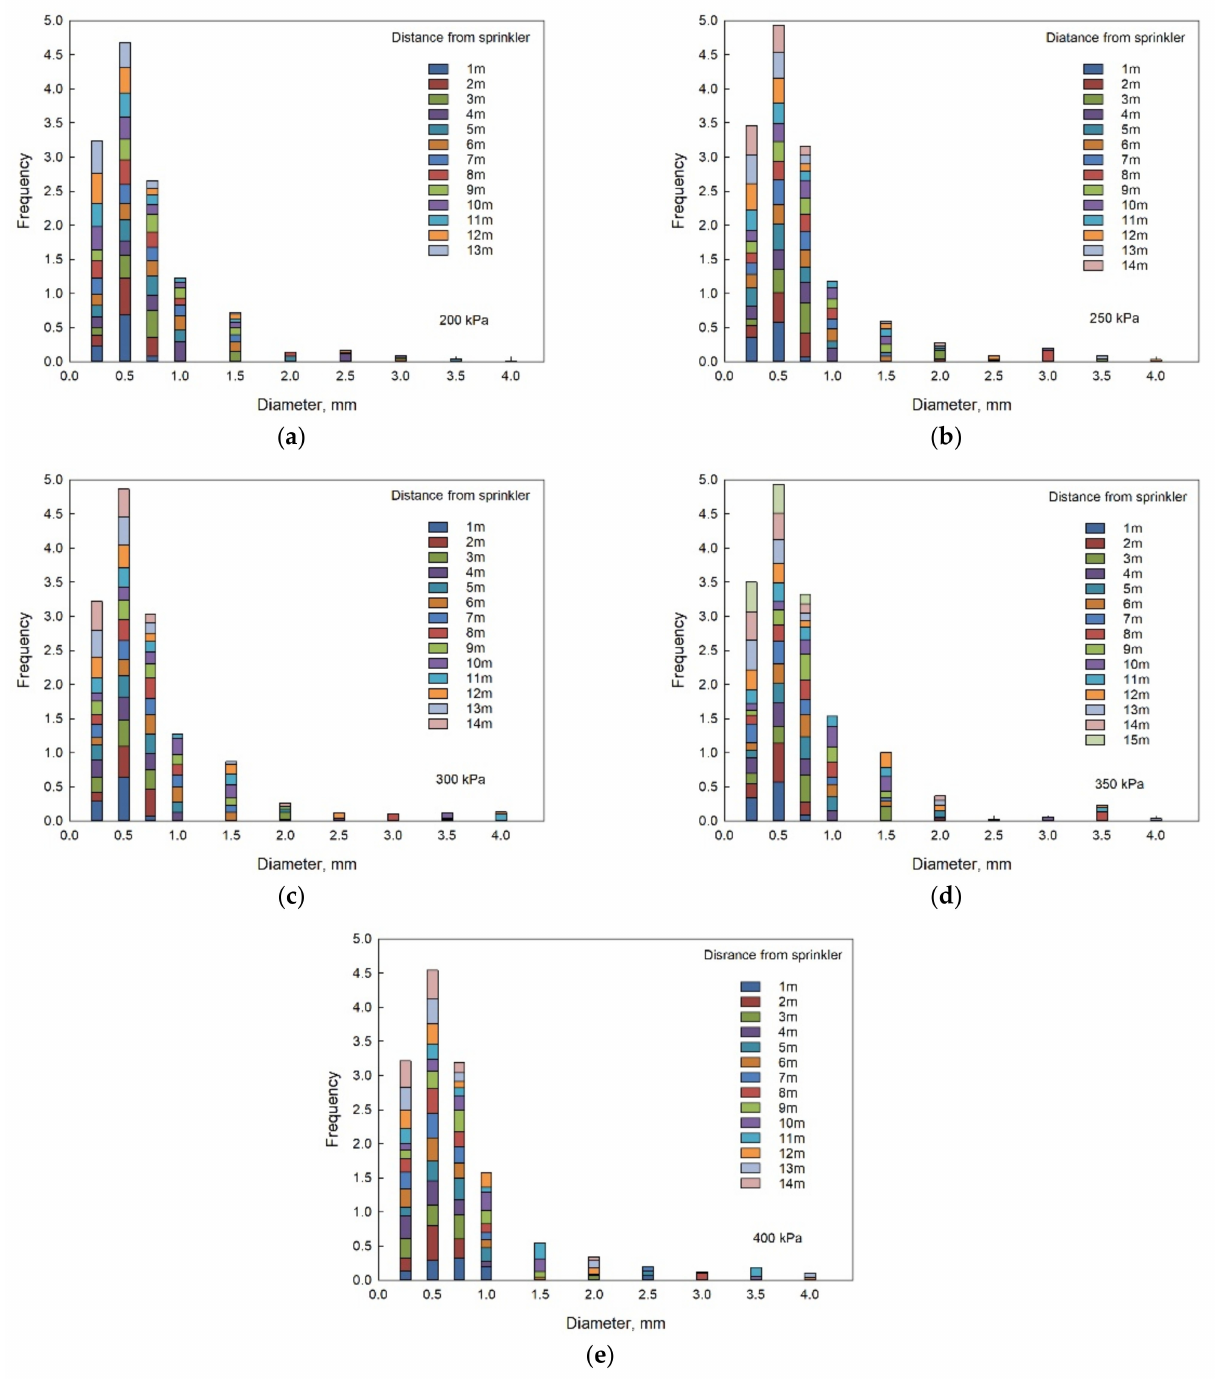
Figure 5. Droplet quantity frequency of the sprinkler with the nozzle size of 5.2 mm under the working pressures of ( a ) 200 kPa, ( b ) 250 kPa, ( c ) 300 kPa, ( d ) 350 kPa and ( e ) 400